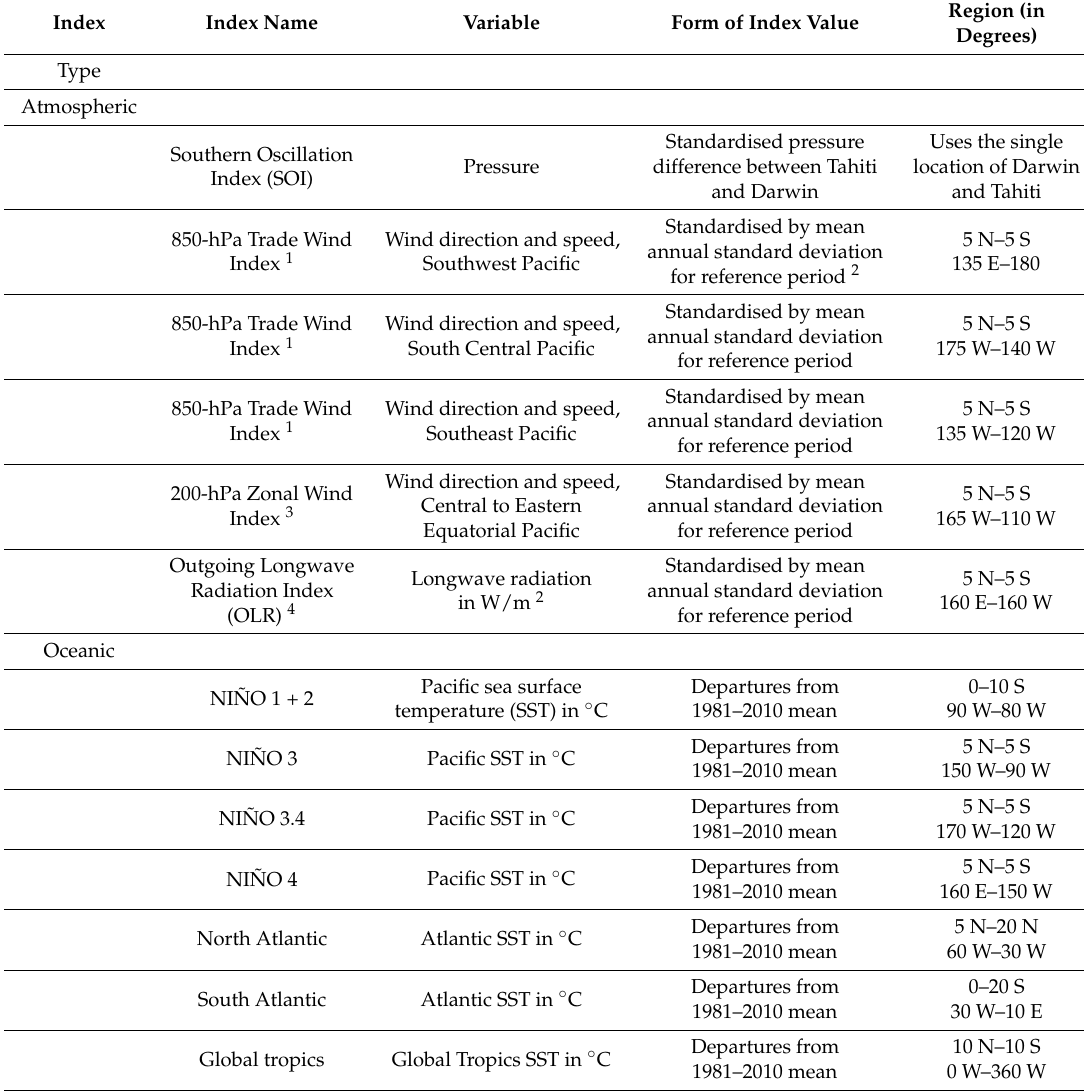
Table 2. El Niño Southern Oscillation (ENSO) indices commonly reported by NOAA on a monthly basis. Modified from the Climate Diagnostics Bulletin